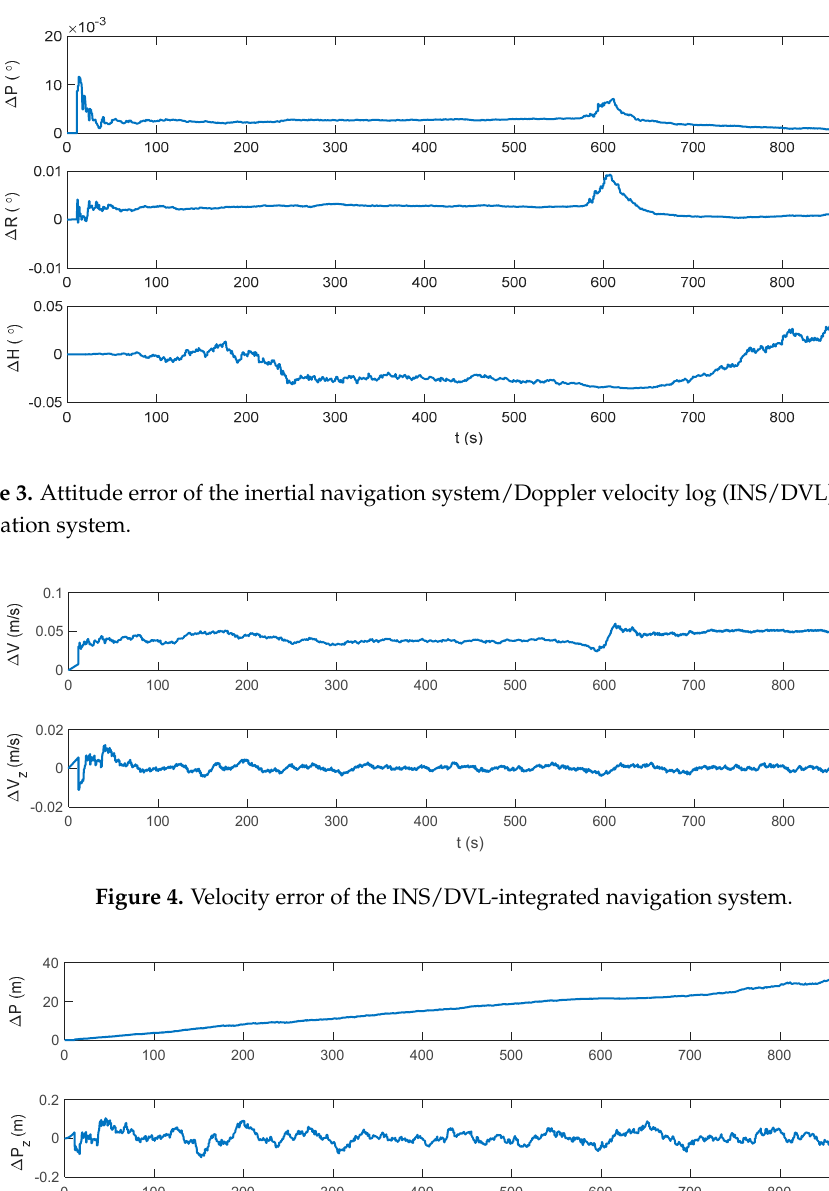
Figure 2. Navigation trajectory.